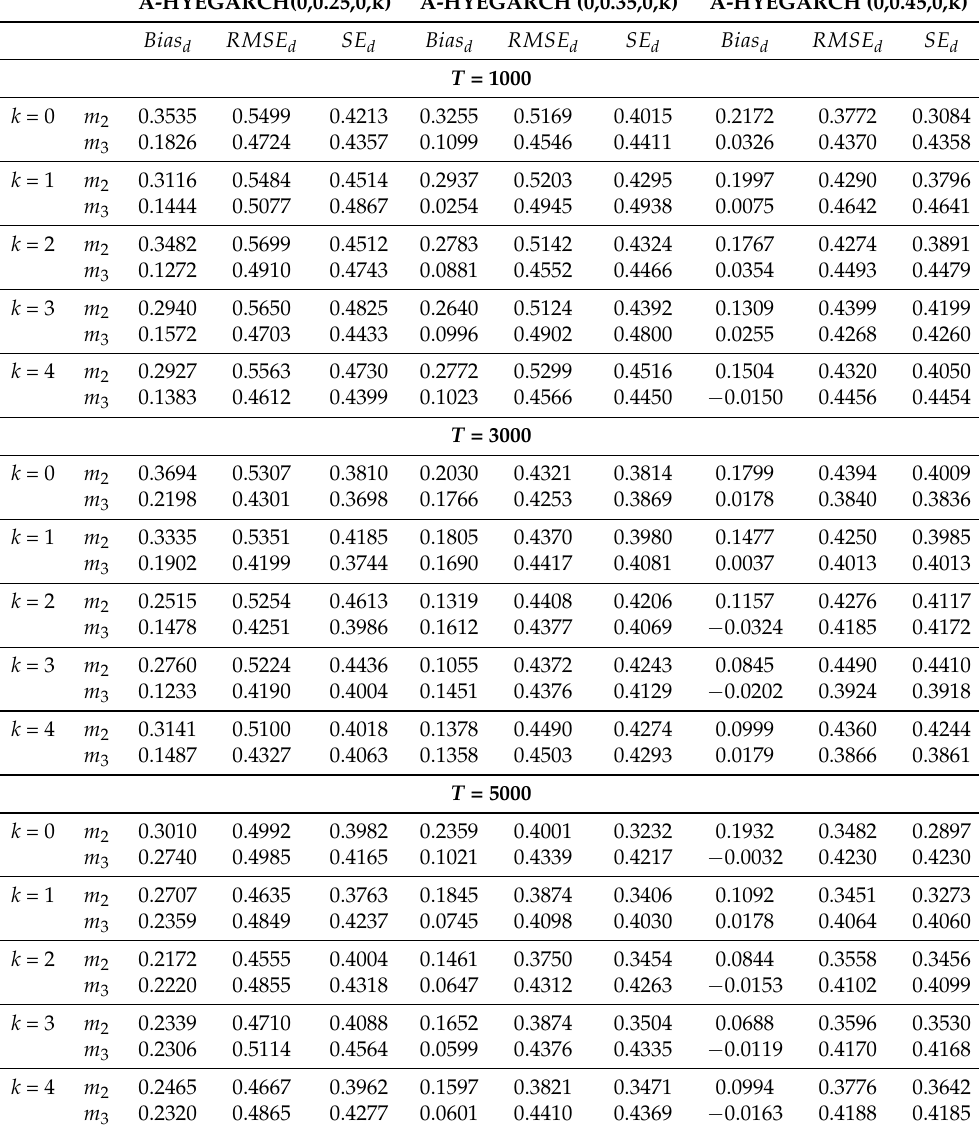
Table 3. Simulation results for estimation of A-HYEGARCH ( 0, d ,0, k ) models with various structural change